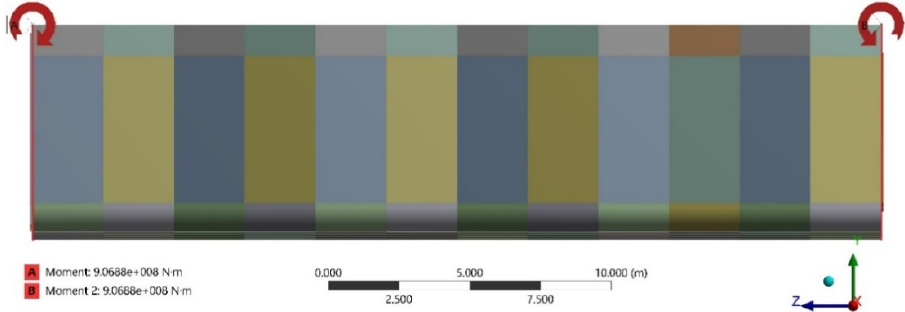
Figure 10. Total vertical bending moment applied to the longitudinal stiffeners and hull placed in the ends of the FEM model for a sagging condition.